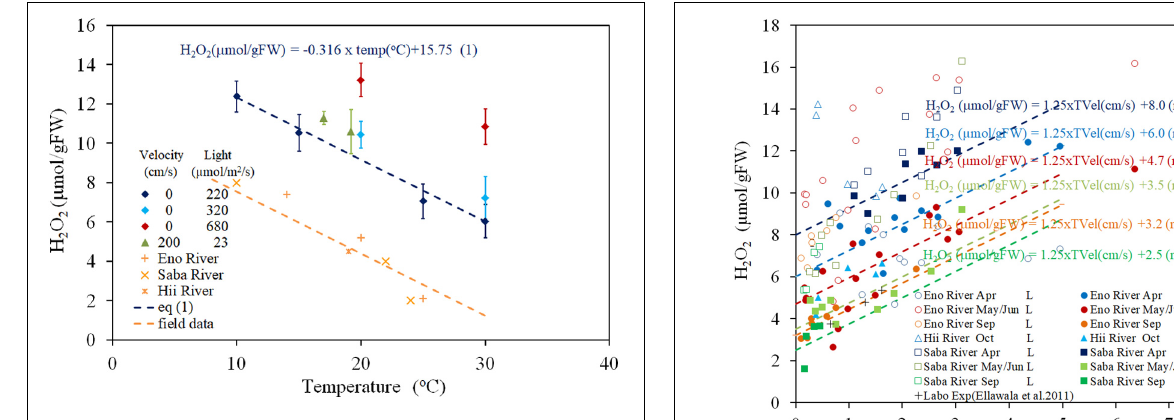
FIGURE 1 | The concentration of H 2 O 2 in E . densa tissue as a function of water temperature. The error bars represent the standard deviation ( n = 3). Eno, Hii, and Saba Rivers data are values extrapolated to zero velocity of the regression line with –0.316 ( µ mol/gFW cm/s) gradient, shown by dashed lines in Figure 2 .